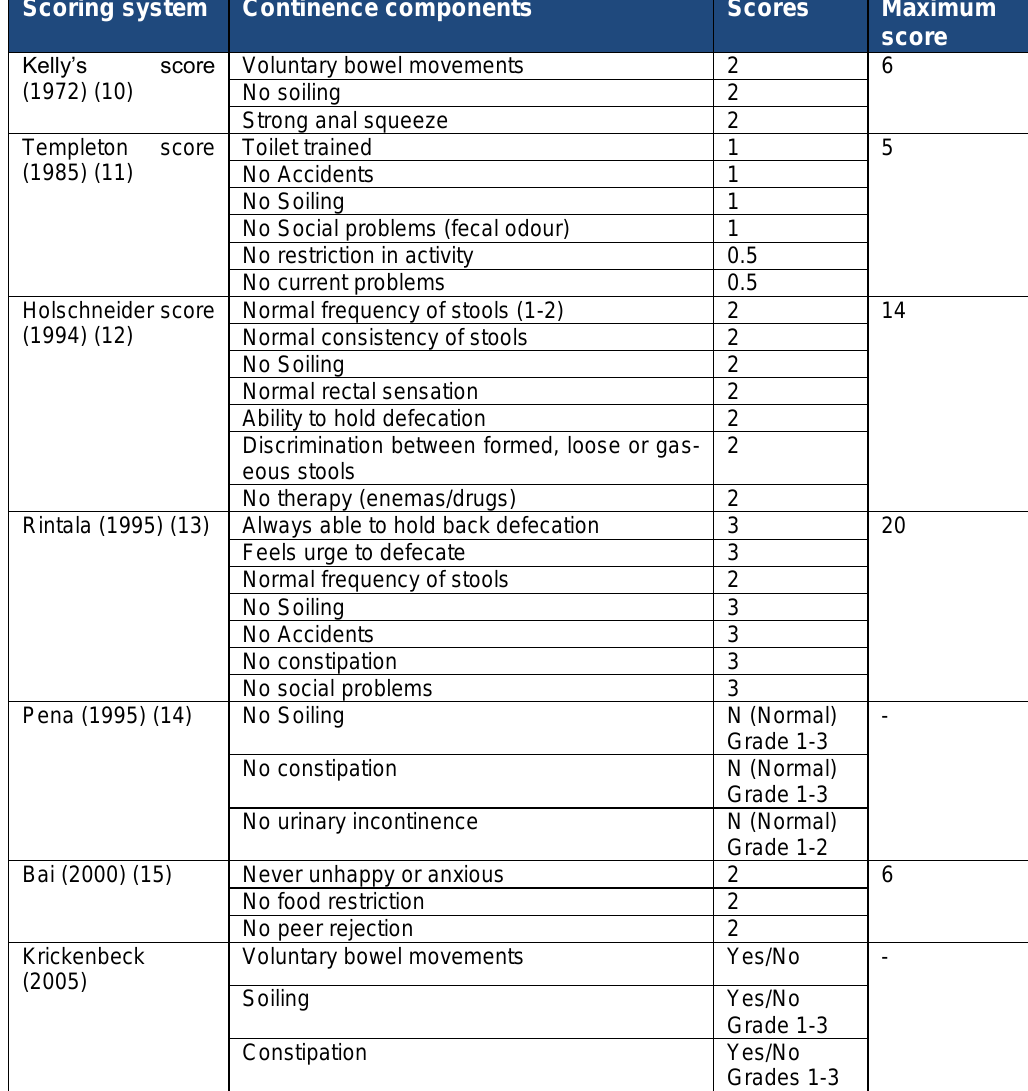
Table 4: Overview of the scoring